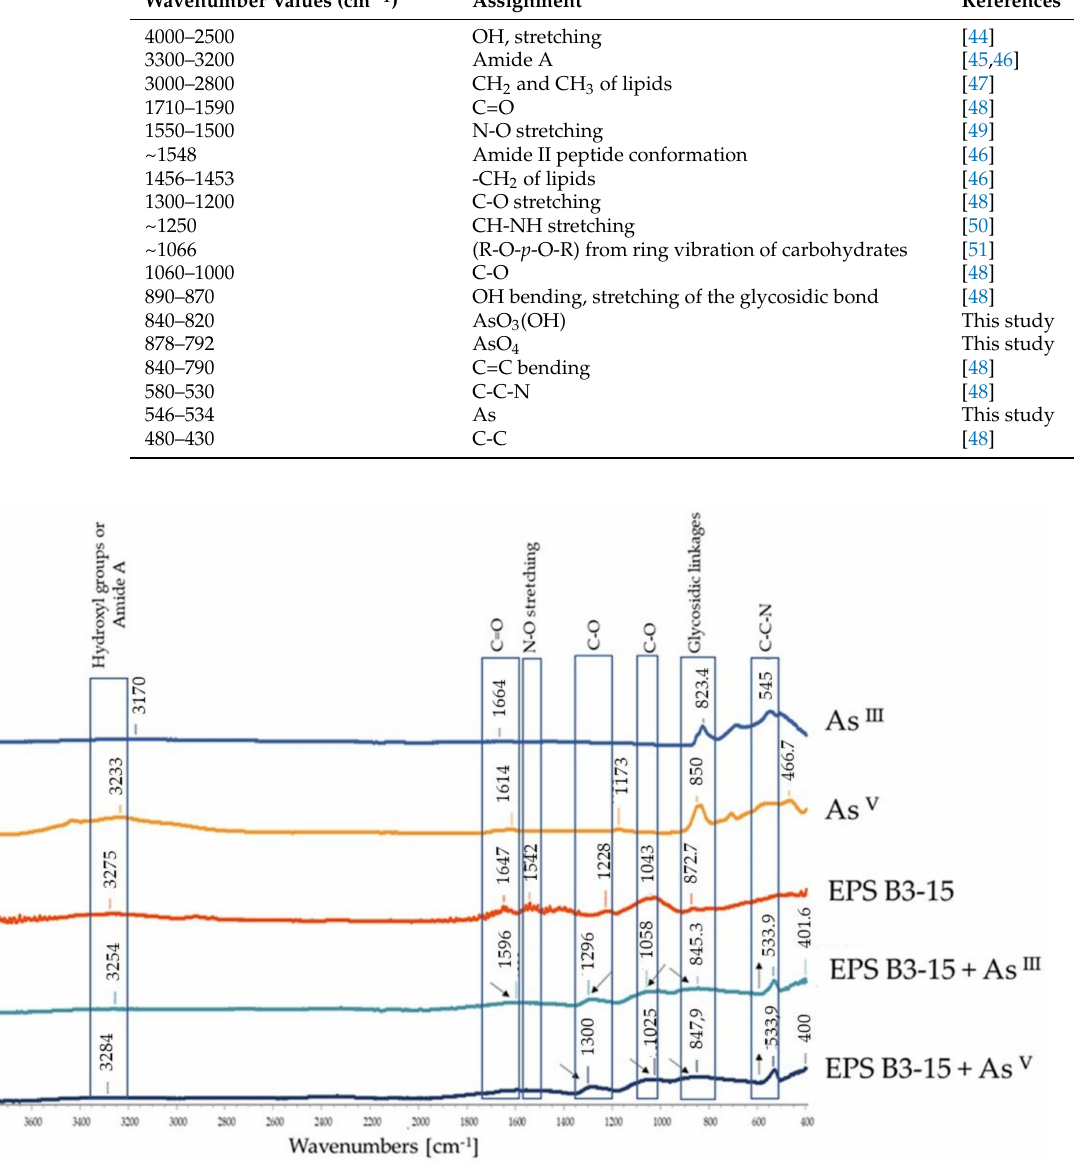
Figure 3. Comparison of the ATR-FTIR spectra of: ( a ) As III , ( b ) As V , ( c ) EPS B3-15 (300 µ g mL − 1 ), ( d ) in the presence of arsenic As III , or ( e ) As V (2000 µ g mL − 1 ). The main changes in the spectra are indicated as new (up arrows) or shifted peaks (left or right